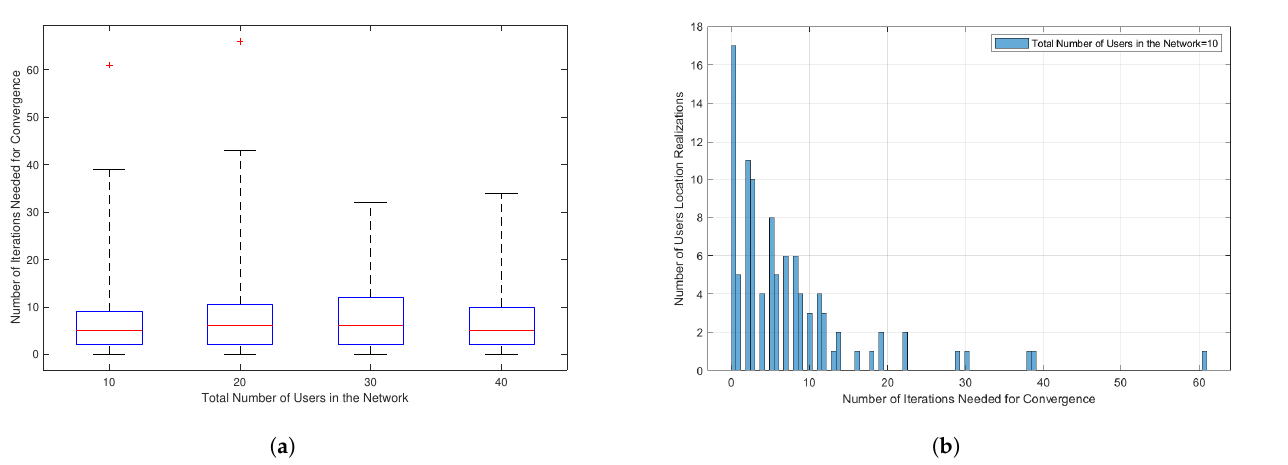
Figure 5. ( a ) Convergence analysis of the user-binding iterative greedy algorithm. ( b ) A detailed look into the number of iterations needed for convergence for the test case of N = 10 in Figure 5a. ( P e = 35 dBm, L = 4, K = 16, φ 1/2 = 60 ◦ , Ψ = 85 ◦ , 100 different users’ location 1/2